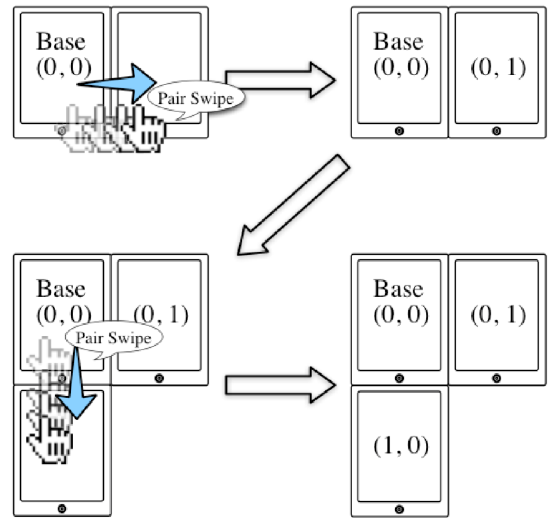
Fig. 2. Making a device matrix by using Pair Swipe